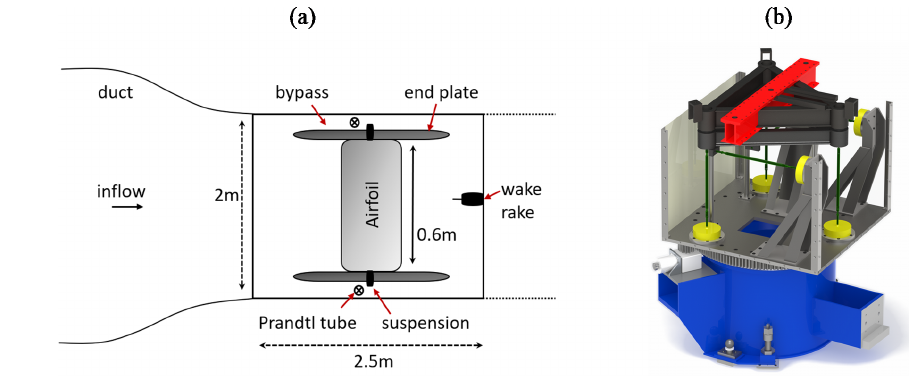
Figure 6. (a) Airfoil test section in top view. (b) Force balance underneath the test section in side view; load cells in yellow, support for attaching the frame of the wing model in red.